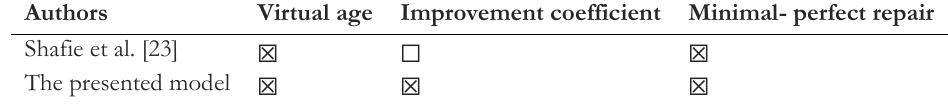
Table 1. Comparing the proposed model and the existing approach